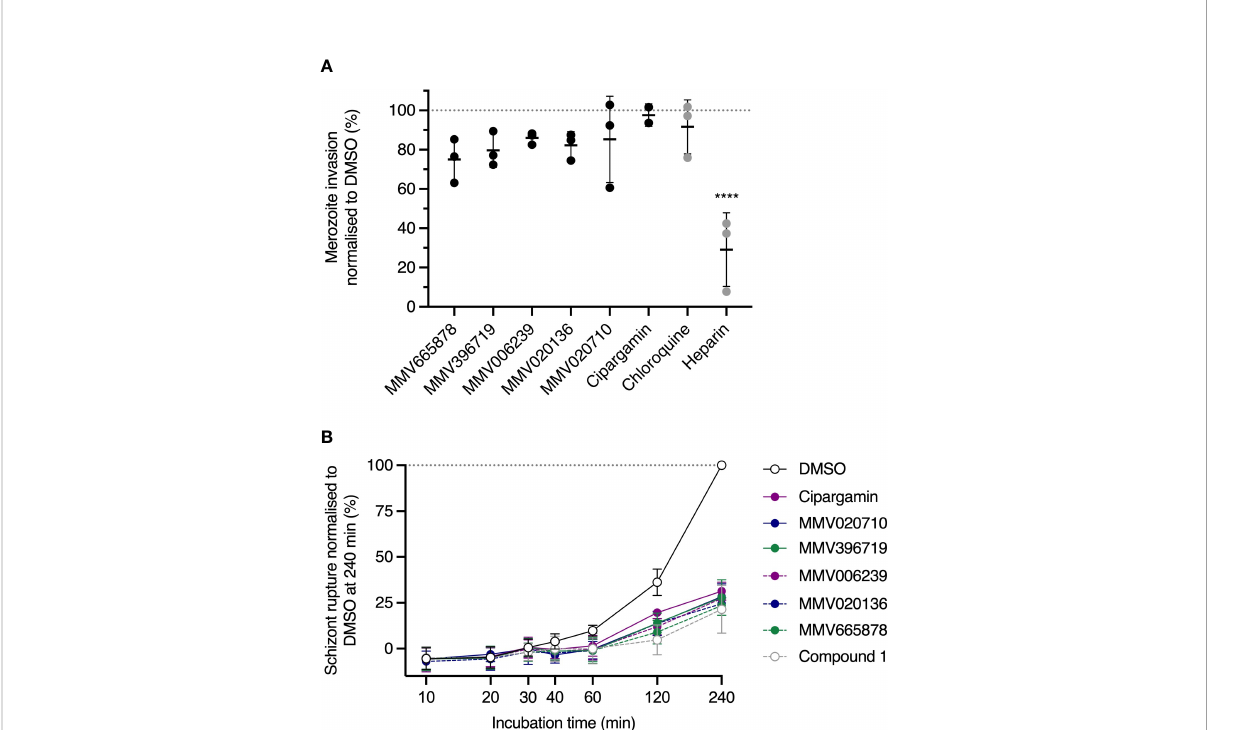
FIGURE 3 Pf ATP4 inhibitors dysregulate 3D7_Hyp1-Nluc merozoite egress but do not directly target merozoite invasion. (A) Mechanically puri fi ed merozoites were allowed to invade RBCs for 30 min in the presence of ~10×IC 50 of Pf ATP4 inhibitors (0.7 m M MMV665878, 3.2 m M MMV396719, 2 m M MMV006239, 3 m M MMV020136, 0.6 m M MMV020710, 10 nM cipargamin). Compounds were then removed and invasion was quanti fi ed 24 h later by measuring the nanoluciferase signals of the trophozoite cultures (cells and medium, with host cells and parasites chemically